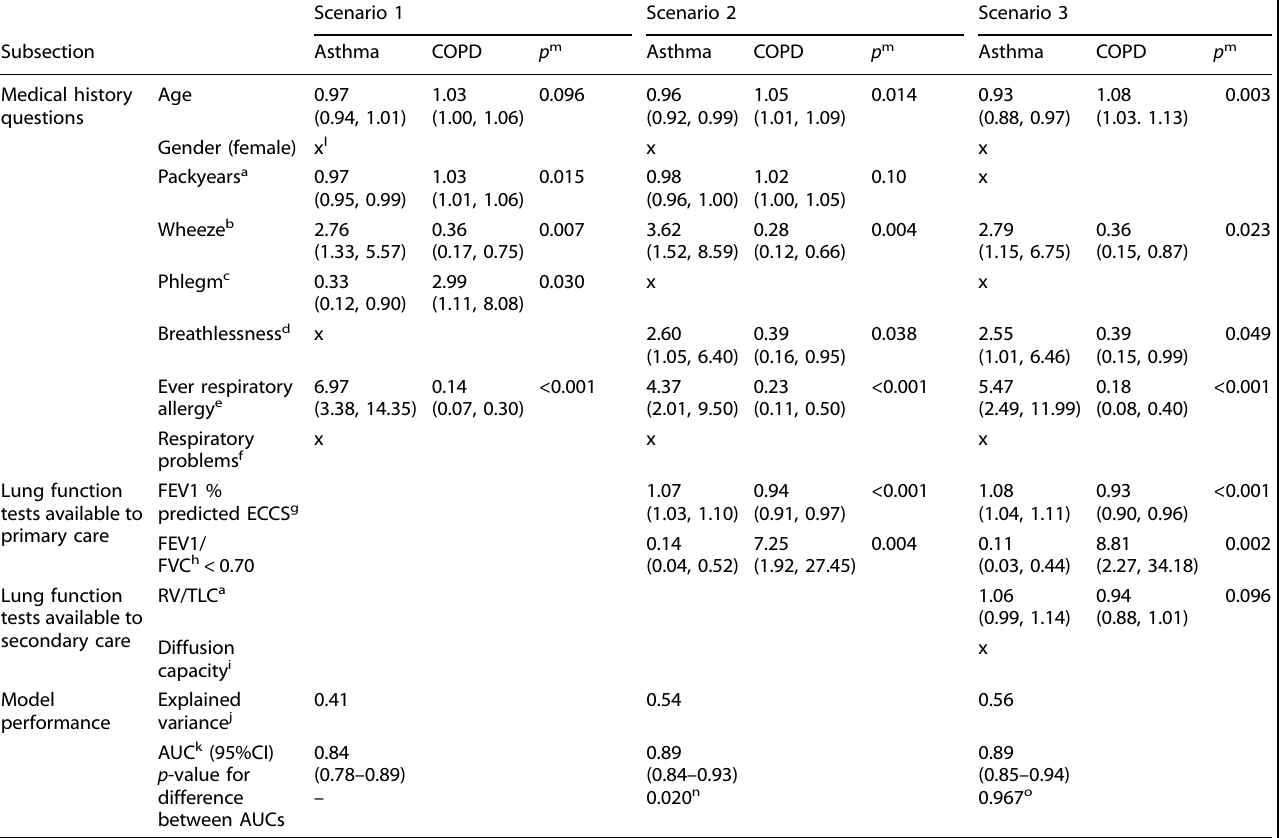
Table 3. Differentiating abilities of relevant items and overall model